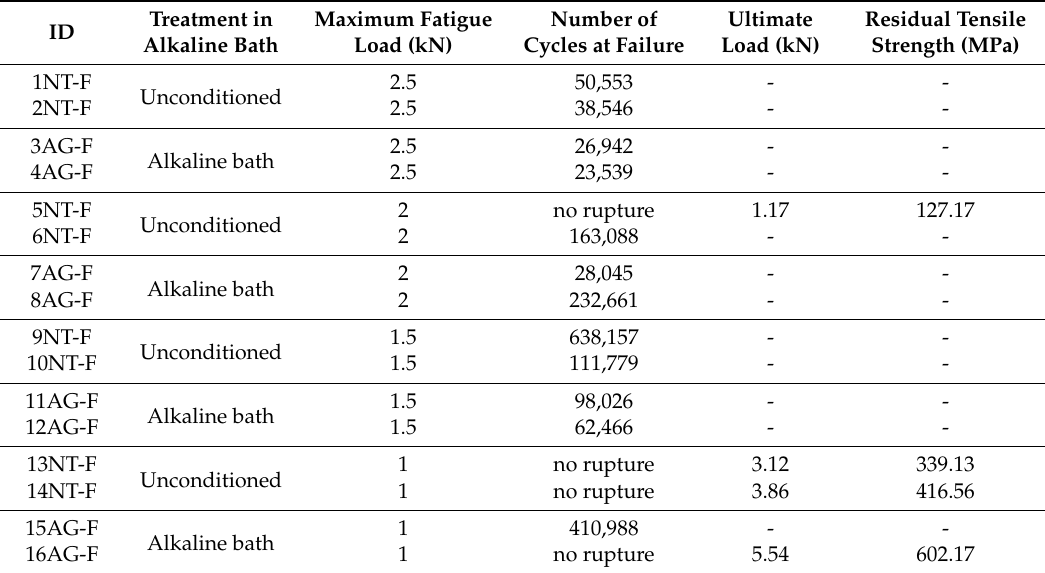
Table 5. Fatigue tests results of reference and aged